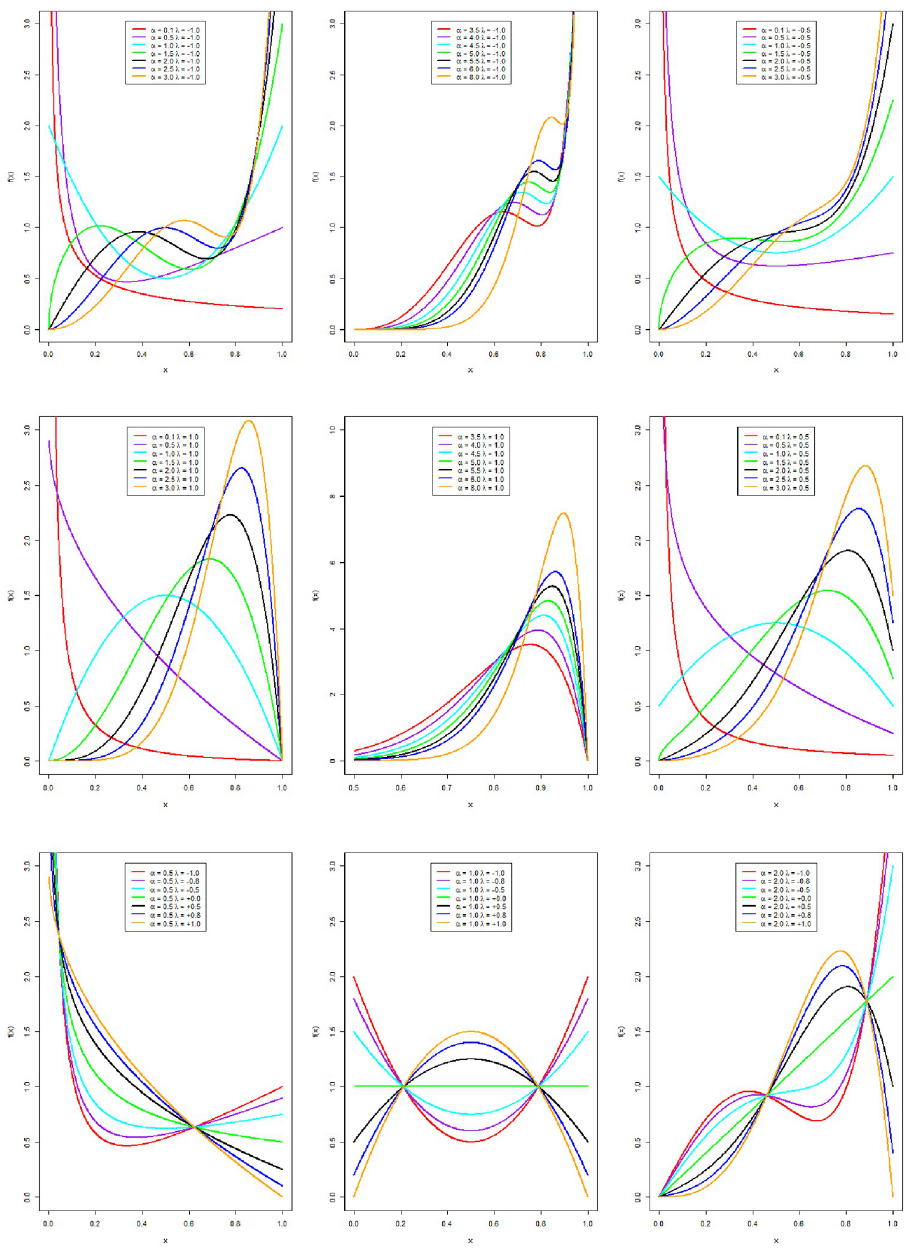
Fig 1. The pdf curves of the NCTPF distribution for different parametric values.